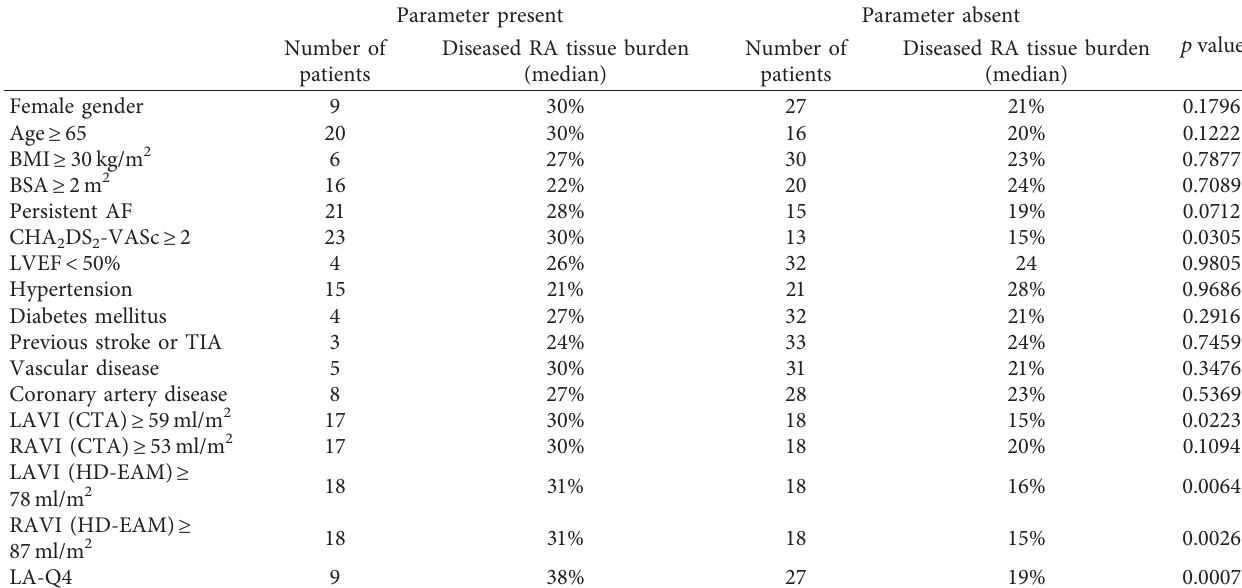
Table 3: Relationship between baseline characteristics and percentage of diseased RA tissue burden ( ≤ 0.5 mV) with p values calculated by the Mann–Whitney U test.